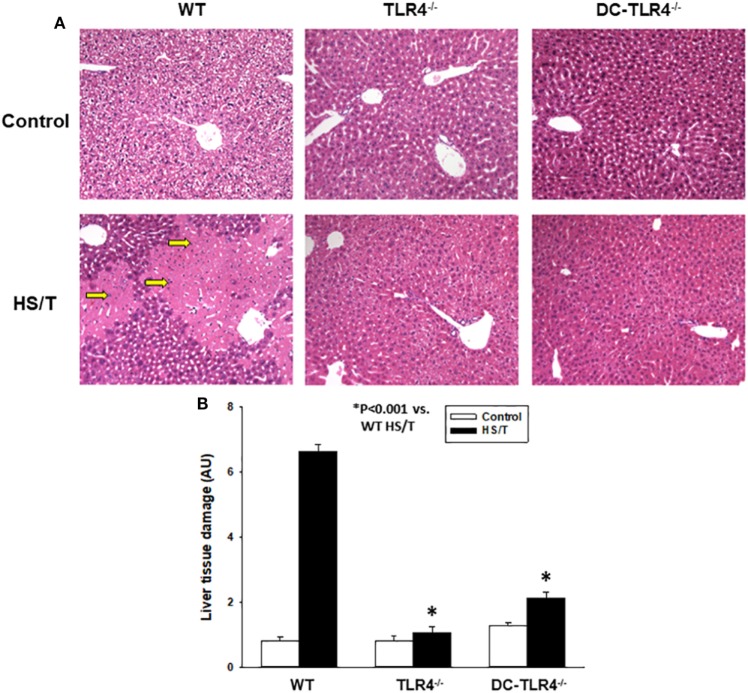
Histopathological analysis of liver in experimental bone marrow (BM) chimeras after HS/T. Liver sections from wild-type and experimental BM chimeras [TLR4−/− and dendritic cell (DC)-TLR4−/−], left untreated (control) or 6 h after HS/T were stained with H&E (A) as described in Section “Materials and Methods.” Images are representative of 7–10 mice per treatment group. Arrows indicate areas of necrosis in liver. Panel (B) shows the quantification of organ damage (*P < 0.001, analyzed by Student’s t-test).